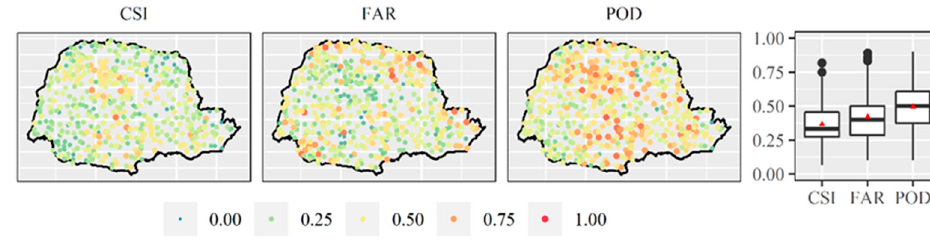
Figure 11. Spatial distribution of performance metrics for anomaly detection.